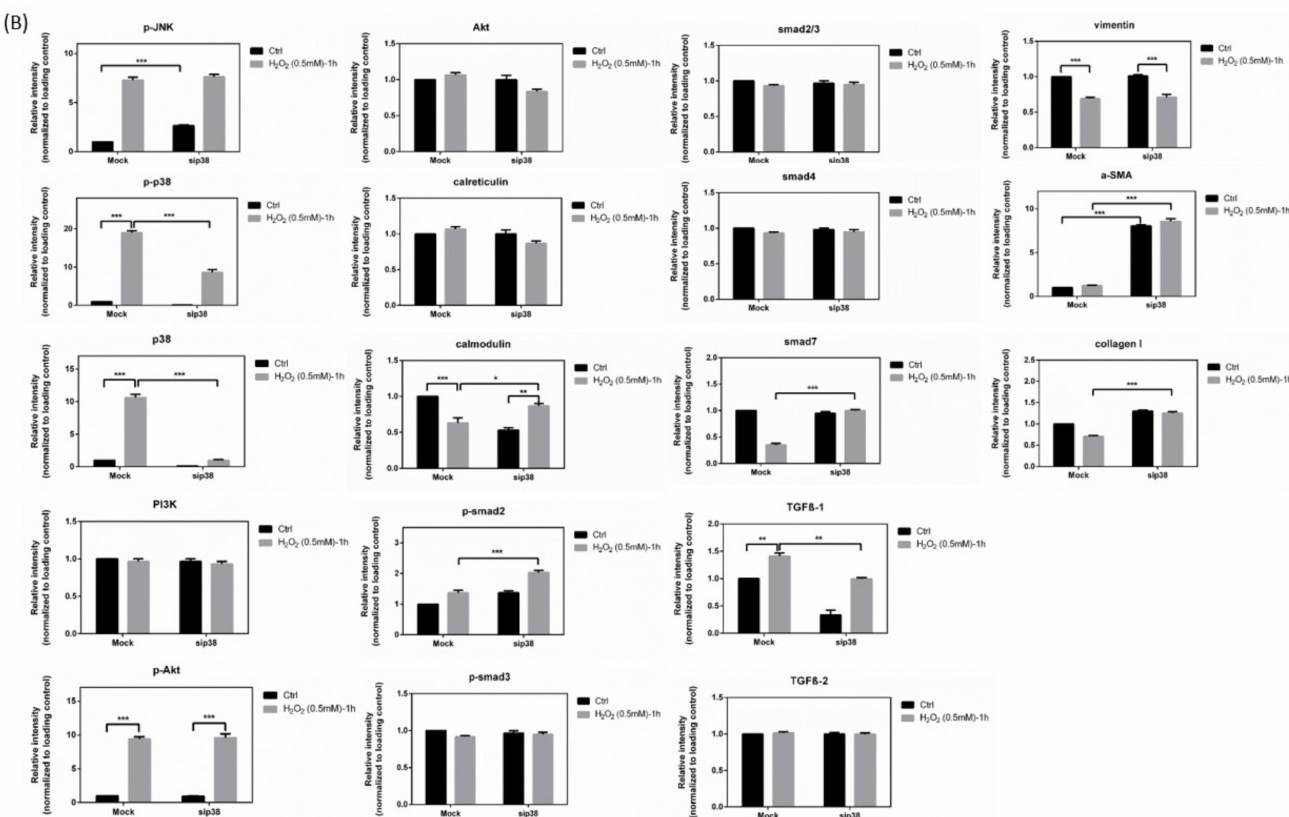
Figure 10. Immunoblot analysis and identification of sip38 MAPK knockdown HTMCs in oxidative stress pathways. ( A ) Si-control (mock) and sip38 MAPK knockdown cells were collected after treatment with H 2 O 2 (0.5 mM) for 1 h, and cellular extracts were immunoblotted with p-JNK, JNK, p-p38, p38, PI3K, p-AKT, AKT, calreticulin, calmodulin, p-SMAD2, p-SMAD3, SMAD2/3, SMAD4, SMAD7, TGF β -1, TGF β -2, vimentin, α -SMA, and collagen I, as shown via protein bands. There was an oxidative stress-dependent increase in ECM proteins ( α -SMA) and stress response, while TGF- β family members were observed to decrease. Numbers under each protein band reflect the densitometry value. ( B ) The protein expression intensities were quantified in relation to the loading control. Statistic chart were represented as means ± SEM. *, p < 0.05; **, p < 0.01; ***, p < 0.001 ( n =